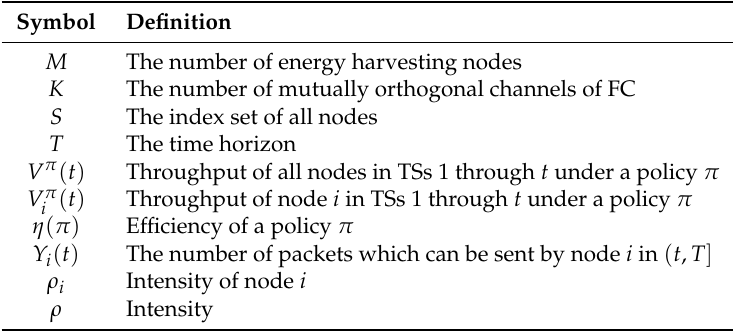
Table 1. Summary of commonly used symbols and